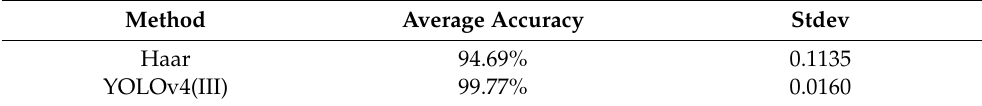
Table 4. Summary of average accuracy using 191 videos.